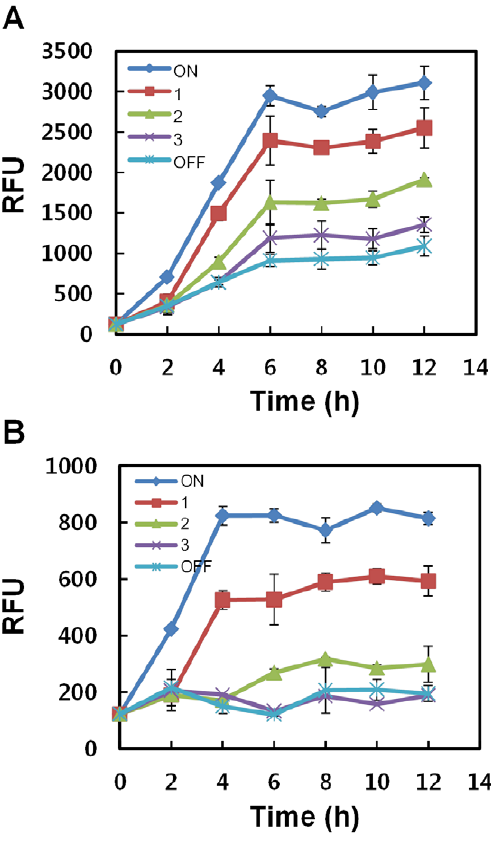
Figure 3. Turn-on control to switch the genes from the OFF state to the ON state. The cells harboring (A) pJM1 with a strong RBS (strain JM1013) or (B) pJM2 with a weak RBS (strain JM1014) were grown overnight in 5 mL of LB medium and subcultured (100:1) into fresh LB medium (2 mL in the light-controllable 24-well plate). The cells were incubated in the microplate for 2 h until OD 600 reached approximately 0.3, and then were initially maintained in darkness for 1, 2, or 3 h, and then, light stimulus was provided until the end of the experiment. Relative fluorescence per unit of OD 600 (RFU) was measured. Data are presented as mean 6 SD and basal values were not subtracted.